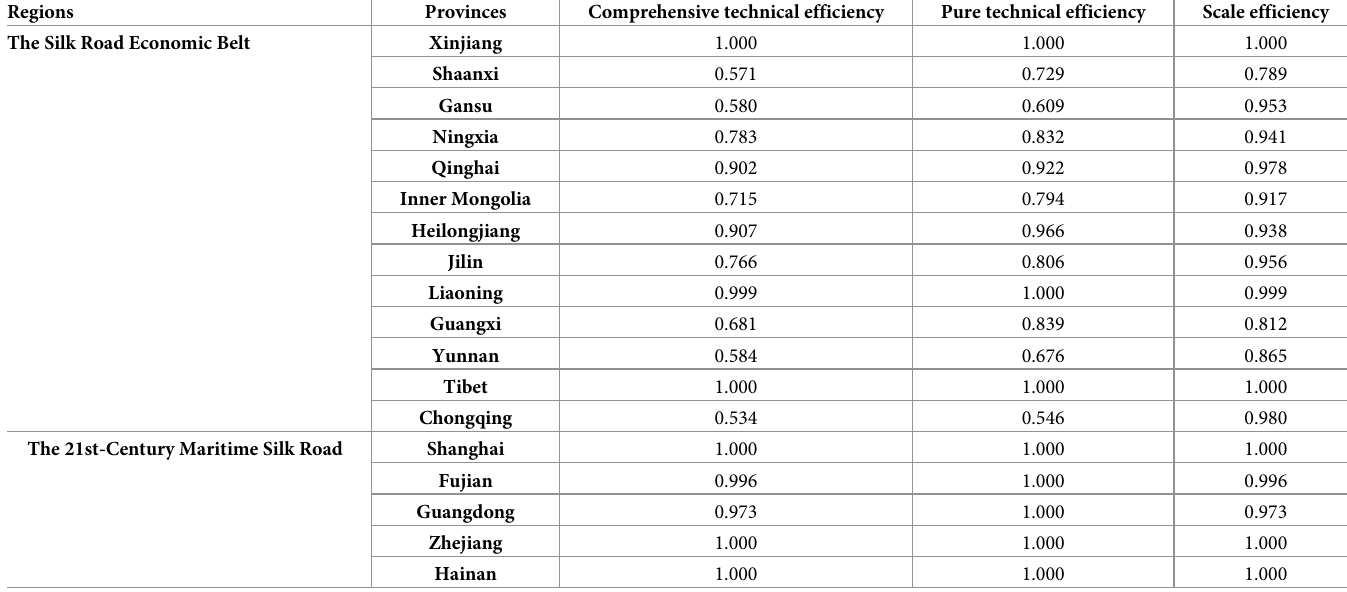
Table 5. Average value of the efficiencies of key provinces along the B&R, 2006–2015. Regions